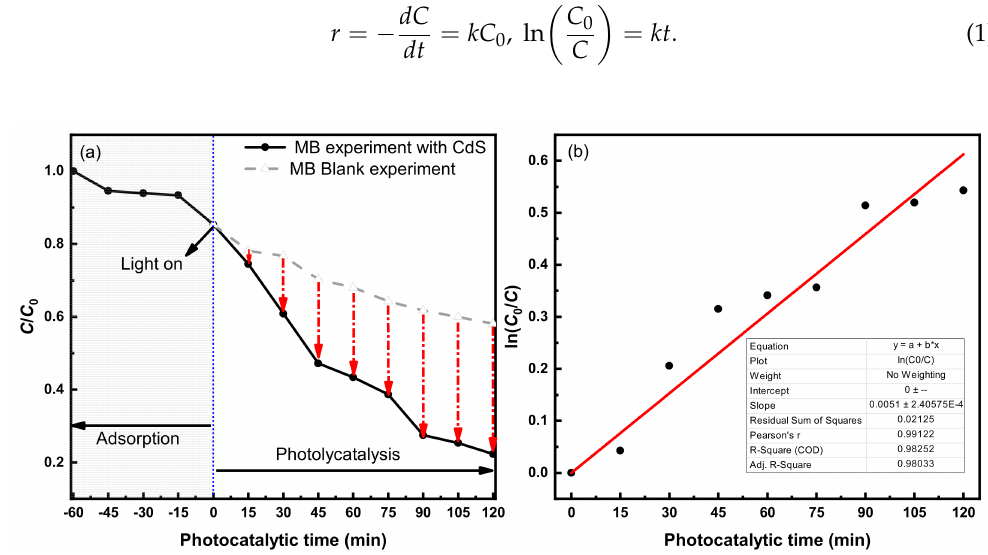
Figure 6. Time-course variation of C / C 0 toward MB (( a ) C / C 0 vs. time; ( b ) ln( C 0 / C ) vs.